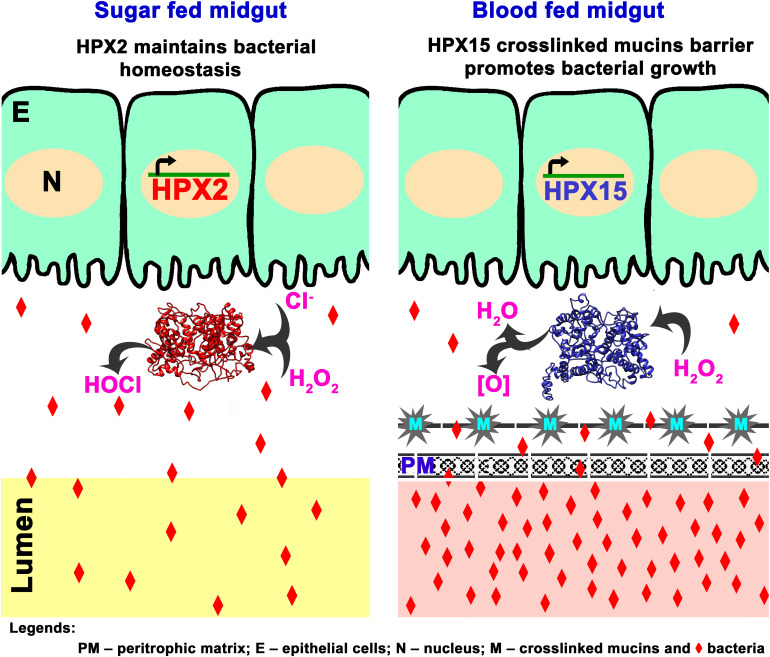
Proposed mechanism of AsHPX2 mediated bacterial homeostasis in An. stephensi midgut. In sugar-fed midguts, AsHPX2 catalyzes the halogenation cycle and produces hypochlorous acid (HOCl) to maintain the bacterial homeostasis. Blood-feeding suppresses the expression of AsHPX2 gene (Figure 5) and induces another heme-peroxidase AsHPX15 (Kumar et al., 2010; Kajla et al., 2016b), which catalyzes mucins crosslinking at the surface of midgut epithelium. Cross-linked mucins act like a barrier that blocks the recognition of bacteria by the immune-reactive epithelium. This mechanism creates a “low immunity zone” in this body compartment to promote the growth of bacteria that, in turn, facilitate blood digestion (Kumar et al., 2010; Kajla et al., 2015). Collectively, the reduced AsHPX2 expression and induced expression of HPX15 in blood-fed midguts create a fine-tuned balance between blood digestion and immunity.